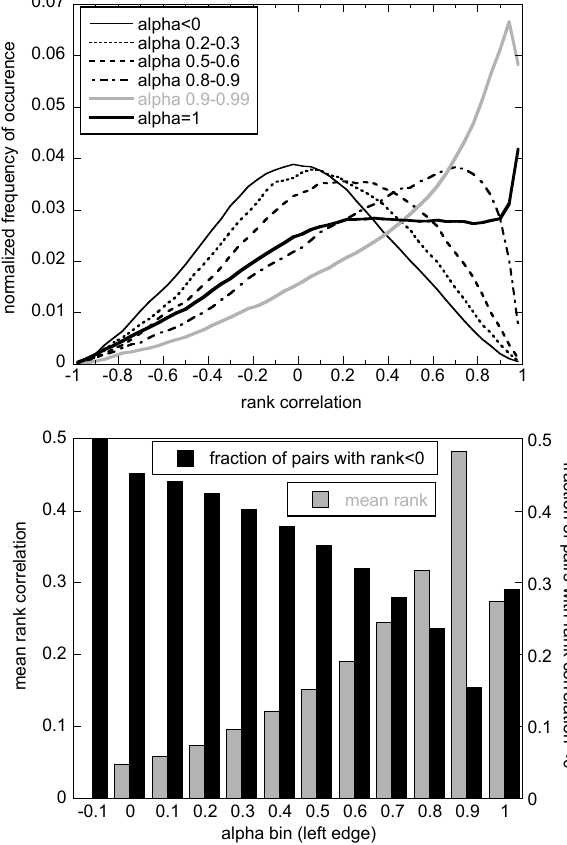
Fig. 7. As in Fig. 6, but for bins of overlap parameter